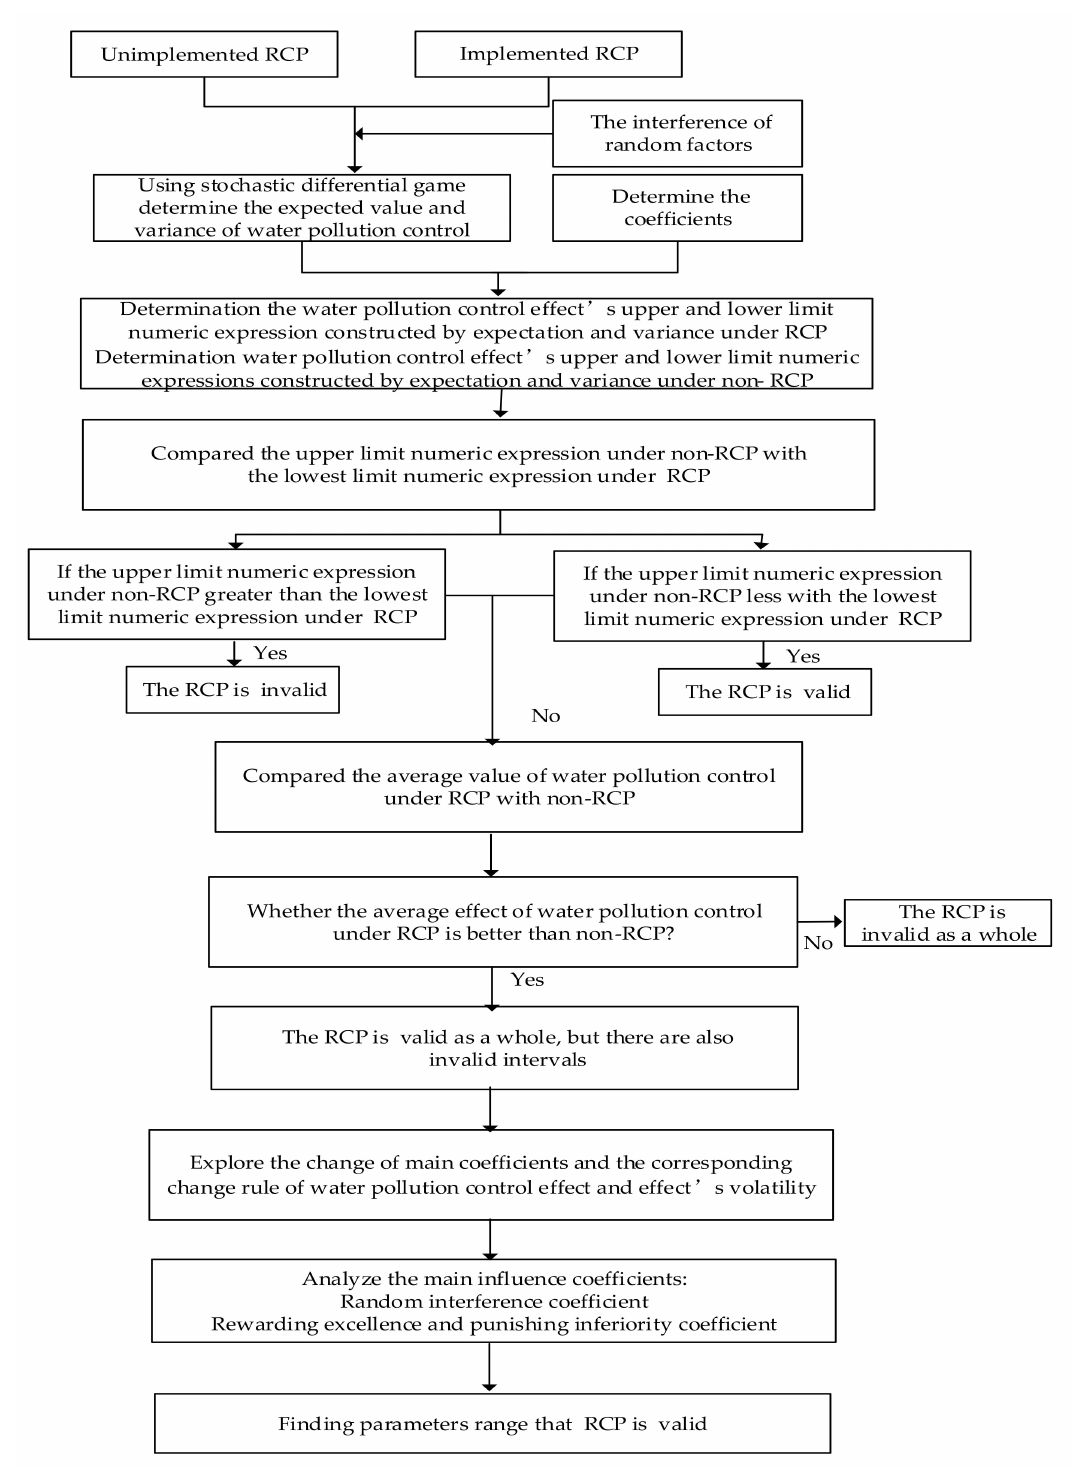
Figure 2. Research framework of this study on the River Chief Policy